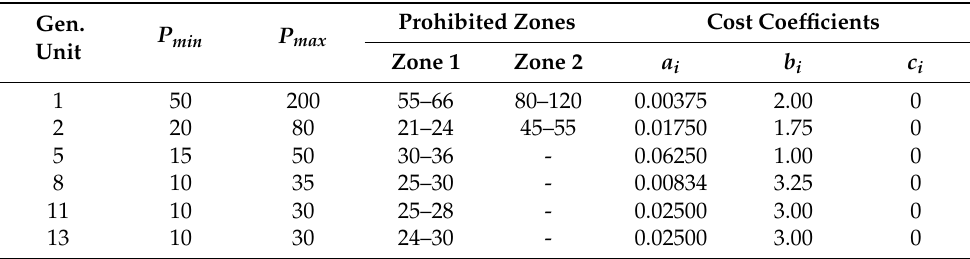
Table 8. Cost coefficients and generating unit limits for the ED problem with the prohibited operating zones (IEEE 30-Bus RTS).